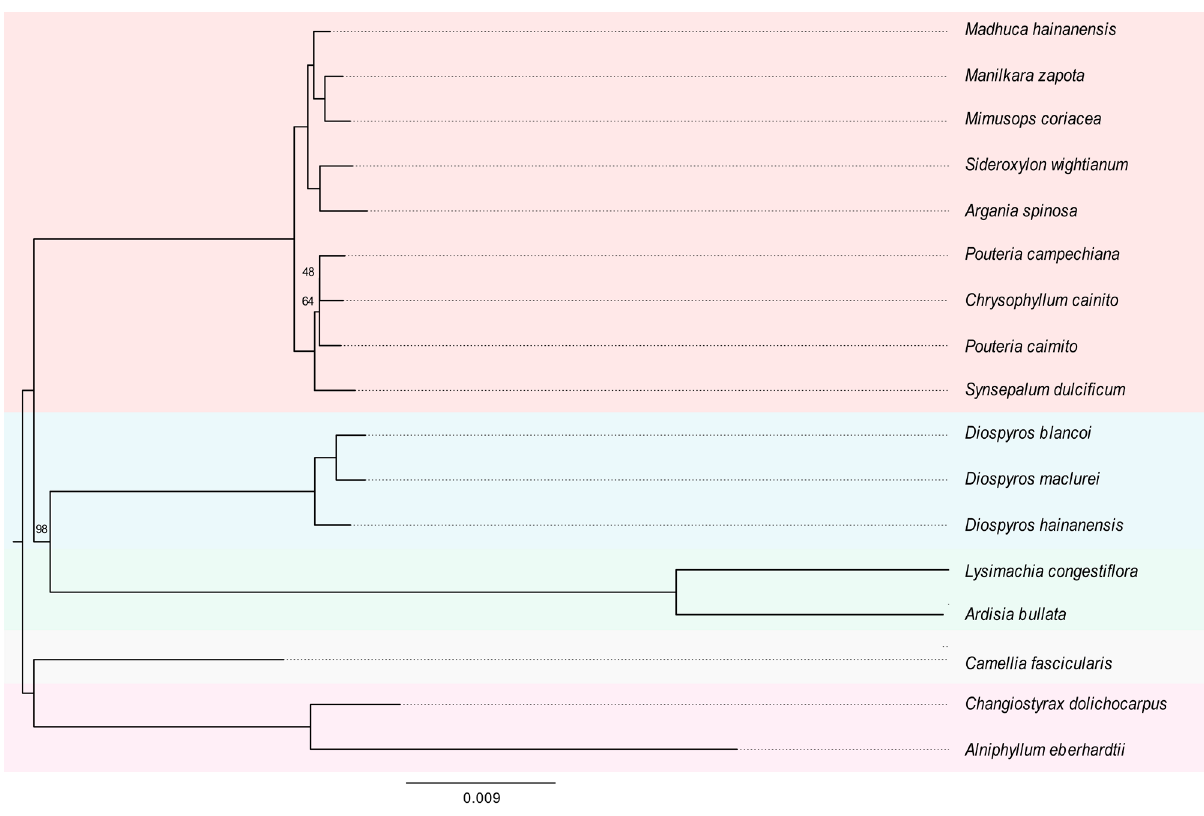
Figure 3 ‒ Phylogenetic tree of 16 Ericales species based on 80 chloroplast protein-coding genes and four rRNAs generated by maximum likelihood method. Numbers above branches represent ultrafast bootstrap support values; nodes with support lower than 100% are indicated. Theaceae and Styracaceae were used as outgroups. The background was colored as follows: Sapotaceae – red, Ebenaceae – blue, Primulaceae – green, Theaceae – gray, Styracaceae –